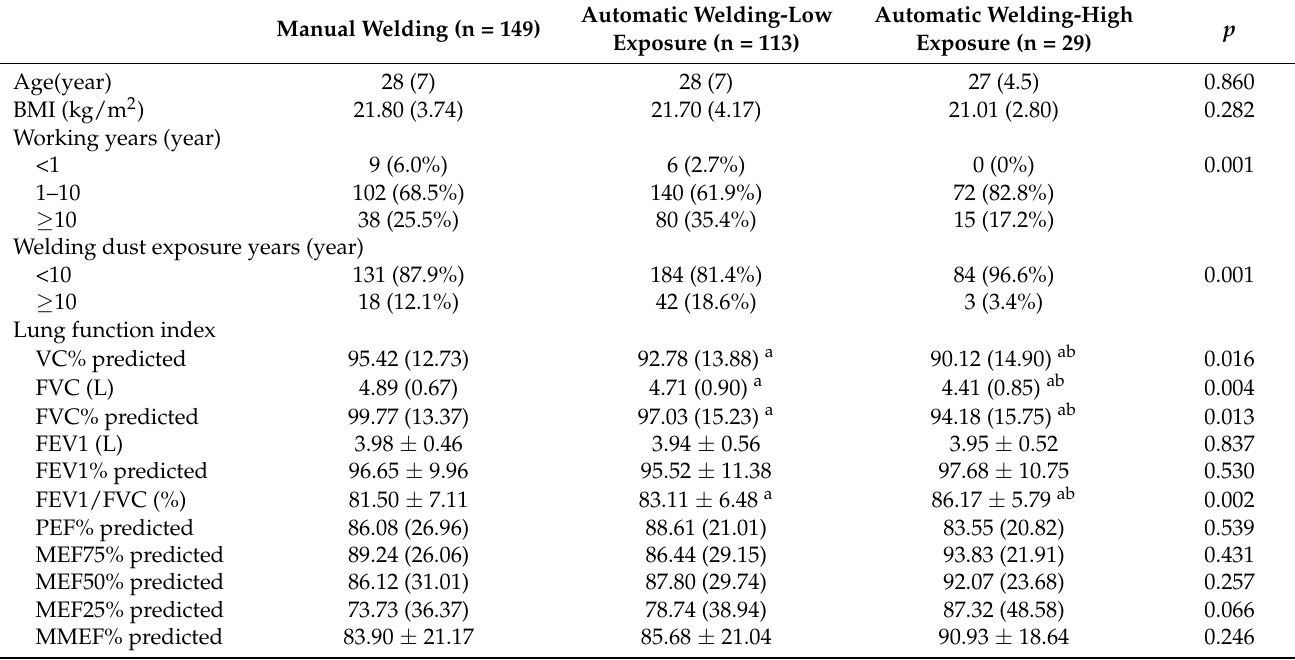
Table 4. Demographic characteristics and lung function parameters of welders in each